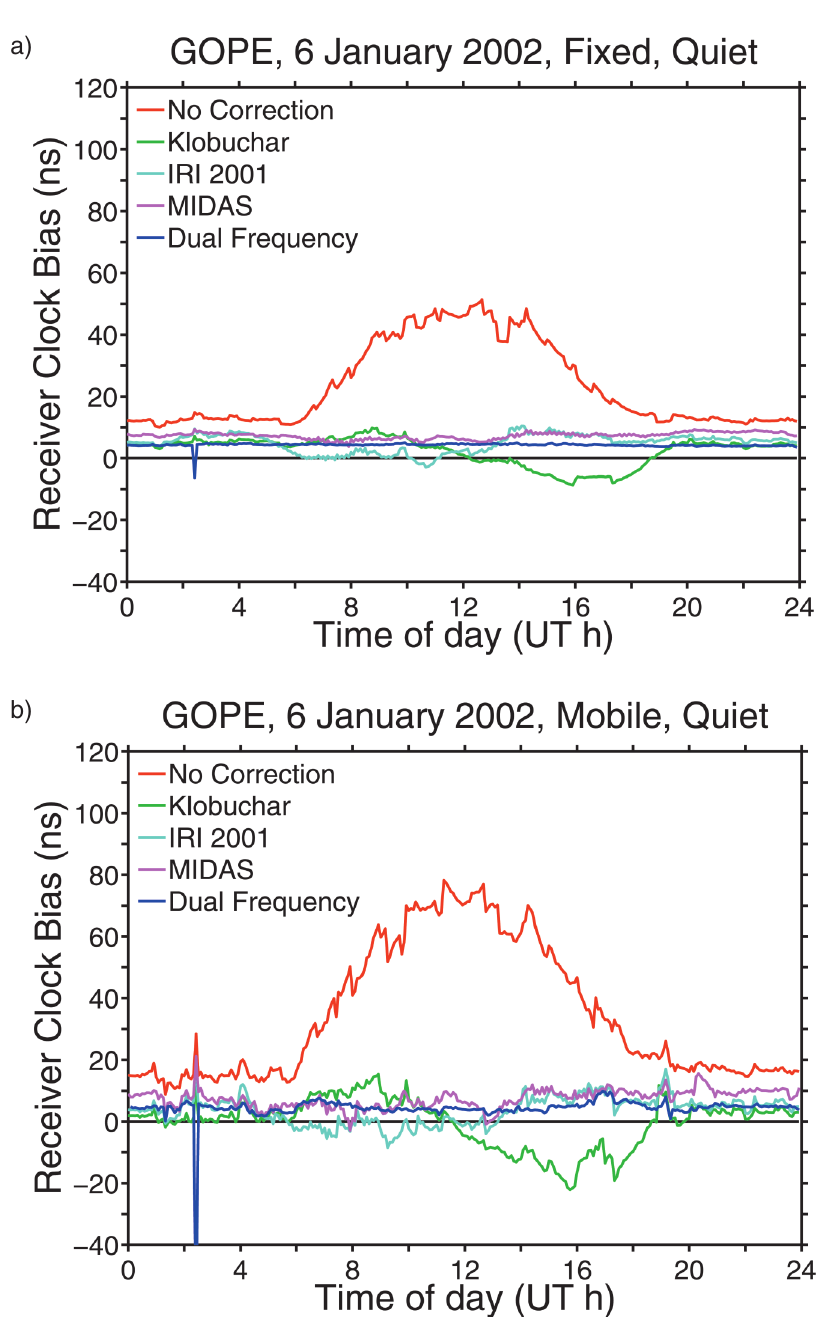
a) Fig. 2a,b. Receiver clock bias referenced to the receiver clock bias from CODE for GOPE 6 January 2002, for a quiet ionosphere (Kp index 0-1.3) using a fixed (a) and mobile (b) GPS receiver solution.